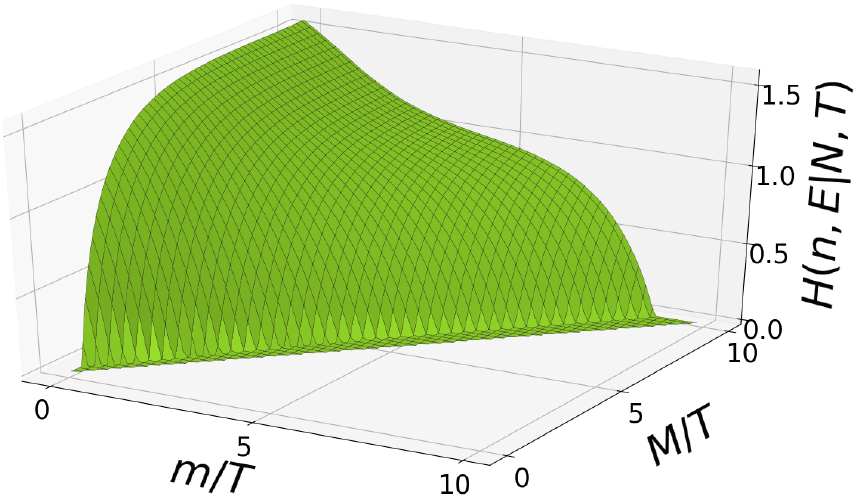
Figure 1. (Color online) The entropy H ( n , E | N , T ) of Unruh radiation given by Equation (17) for fermions ( N = 2 ) as function of m / T and M / T